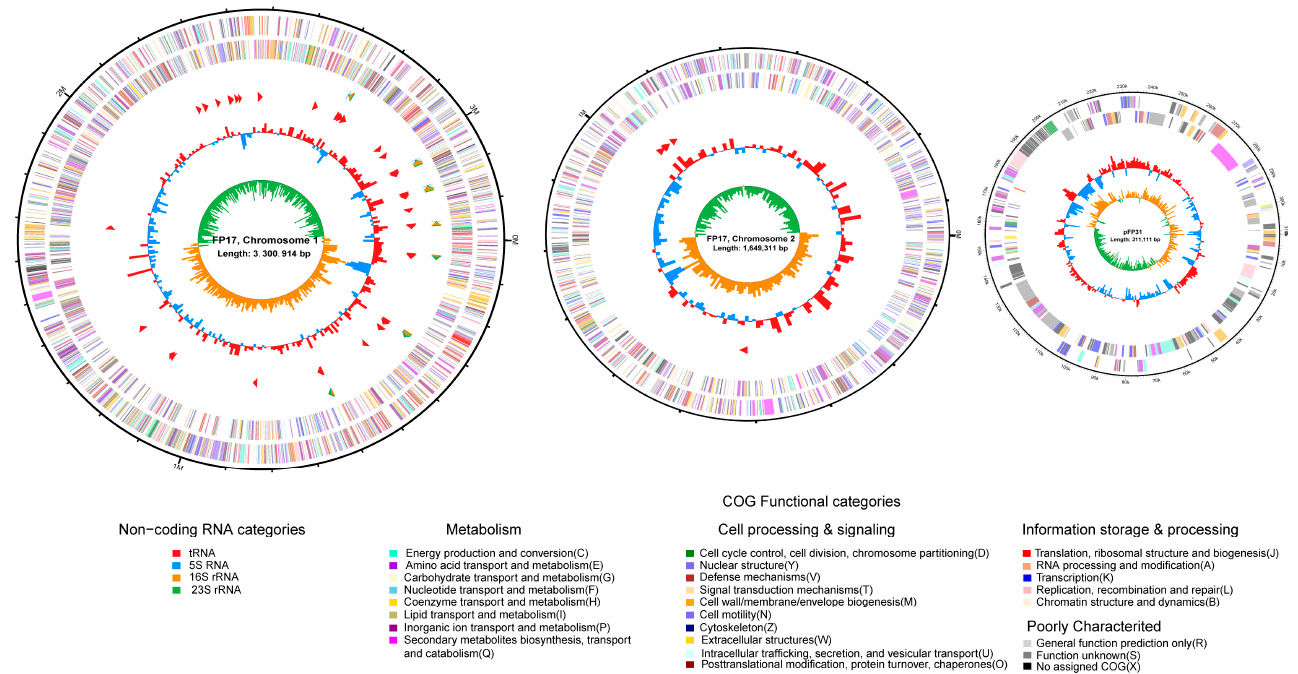
Figure 2. Genome map of V. tubiashii FP17. Chromosomes I, II, and plasmid pFP31 were mapped based on their genomic size. The outermost circle is the identification of the genome size; the second circle and the third circle are the CDS on the positive and negative strands, and the different colors indicate the functional classification of the COG of the CDS; the fourth circle is rRNA and tRNA; the fifth circle is the GC content; the innermost circle is the GC skew value.